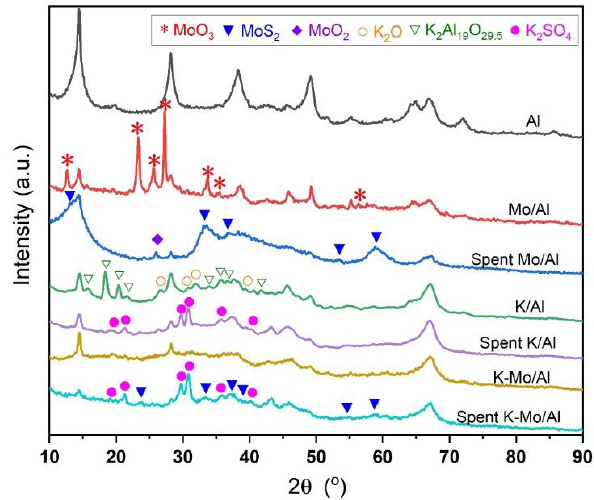
Figure 3. XRD diffraction patterns of the fresh catalysts and the spent catalysts.